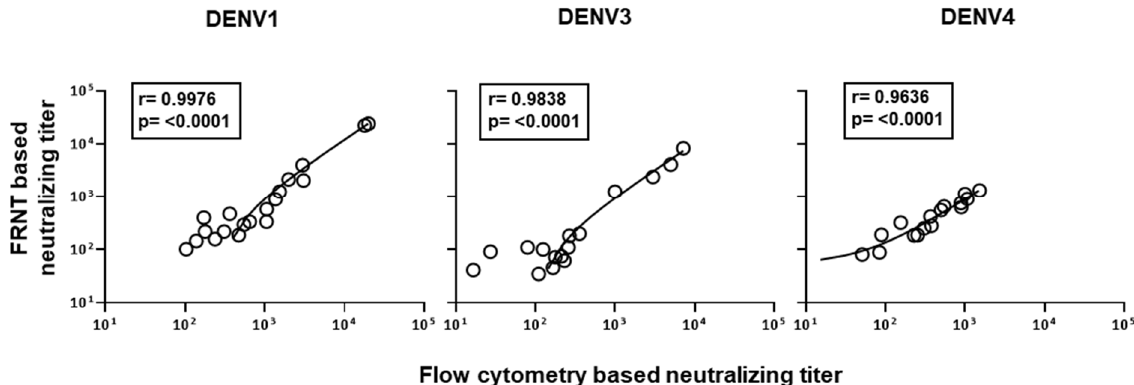
Figure 5. Correlation analysis between the neutralization titers obtained by the newly improved flow cytometry based assays and the standard FRNT for DENV1, DENV3, and DENV4 serotypes. Flow cytometry based neutralization assays were performed using 2000 Vero cells/well at an MOI of 1. Correlation analysis of DENV-1, 3, and 4 serotypes are shown in left, middle, and right graph, respectively.